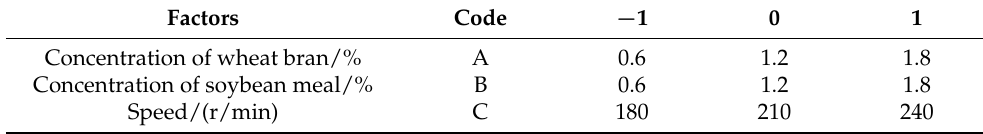
Table 2. Variables and levels for Box–Behnken design for the optimization of parameters. Factors